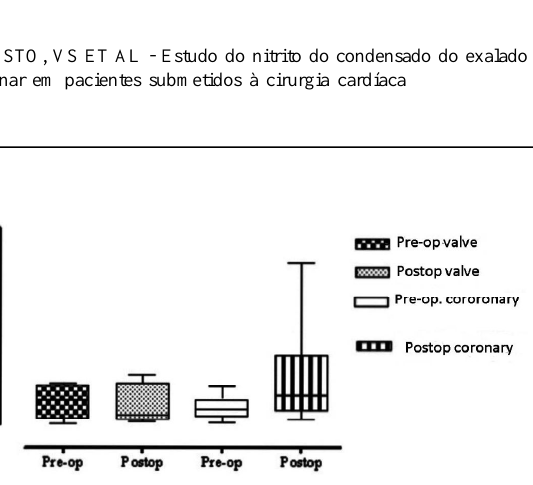
Fig. 5 - Concentrations of NO 2- plasma in the pre and